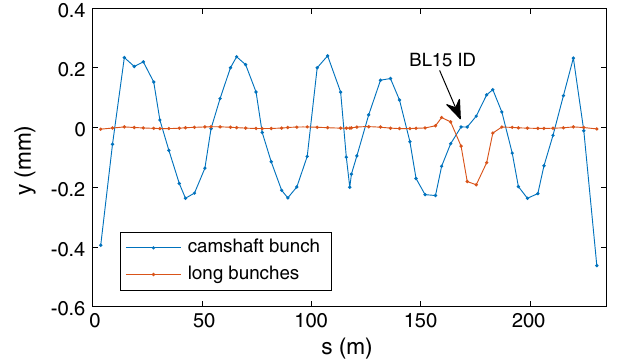
FIG. 12. Separated closed orbits for the camshaft bunch and the regular bunches when the crab cavity phases are shifted by 0.2 rad and a local orbit bump is created at BL15